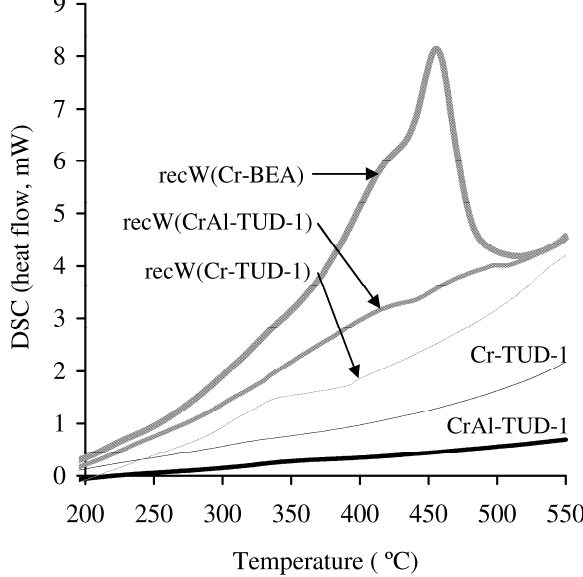
Figure 7. DSC curves for the recW solids related to the chromium containing solid acids (for comparative purposes, exemplified for fresh Cr-TUD-1 and